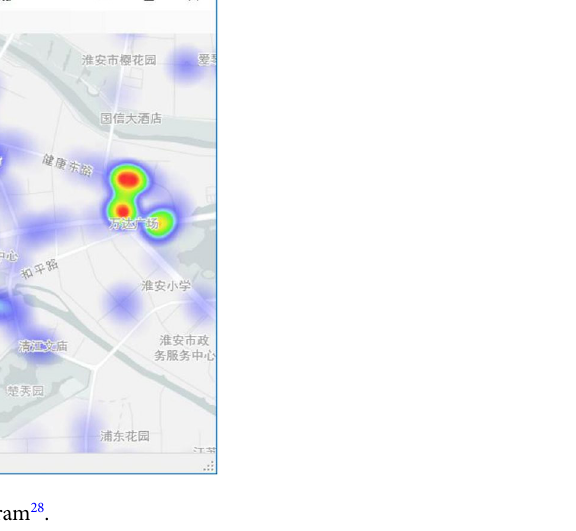
Figure 7. The optimized thermal diagram 28